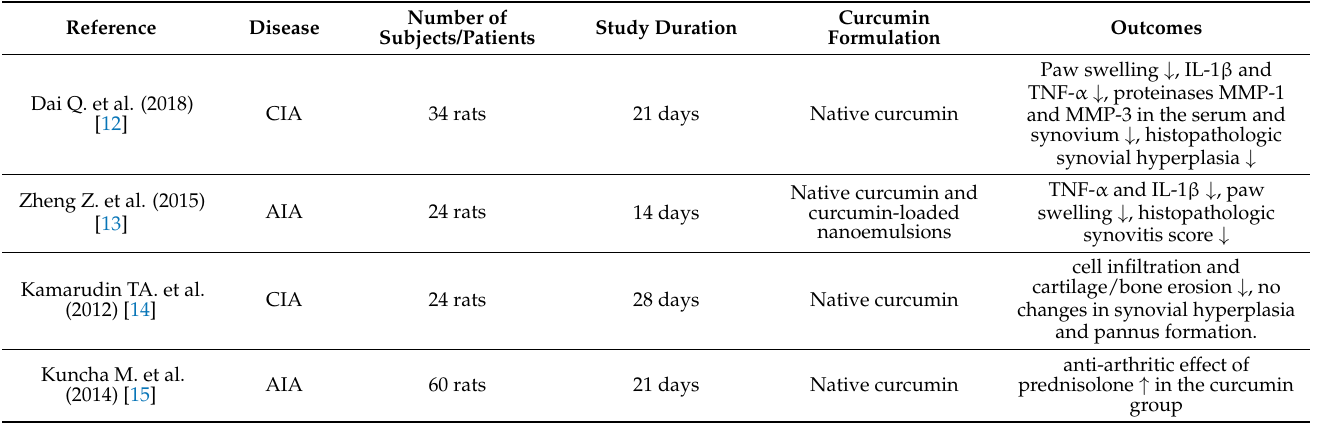
Table 1. Overview of the 15 animal and human trials evaluated in this